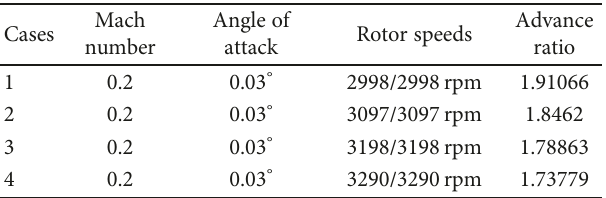
Figure 9: Block-structured grids of an isolated CROR. Table 3: CROR numerical